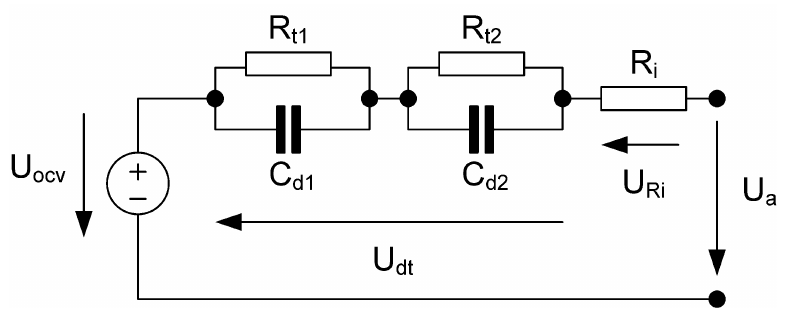
Figure 2. Equivalent circuit model of a battery